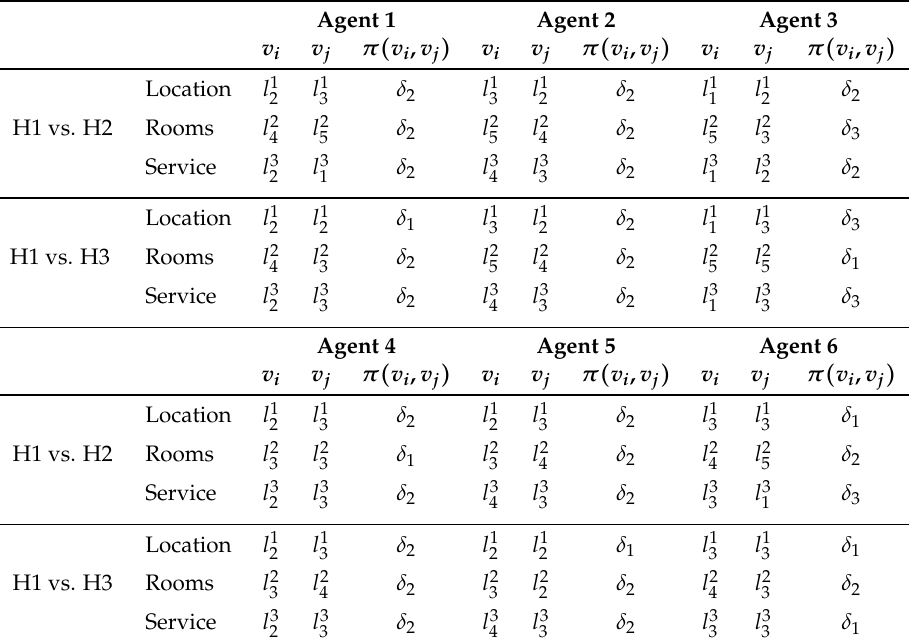
Table 4. δ values obtained for hotel 1. Uniform